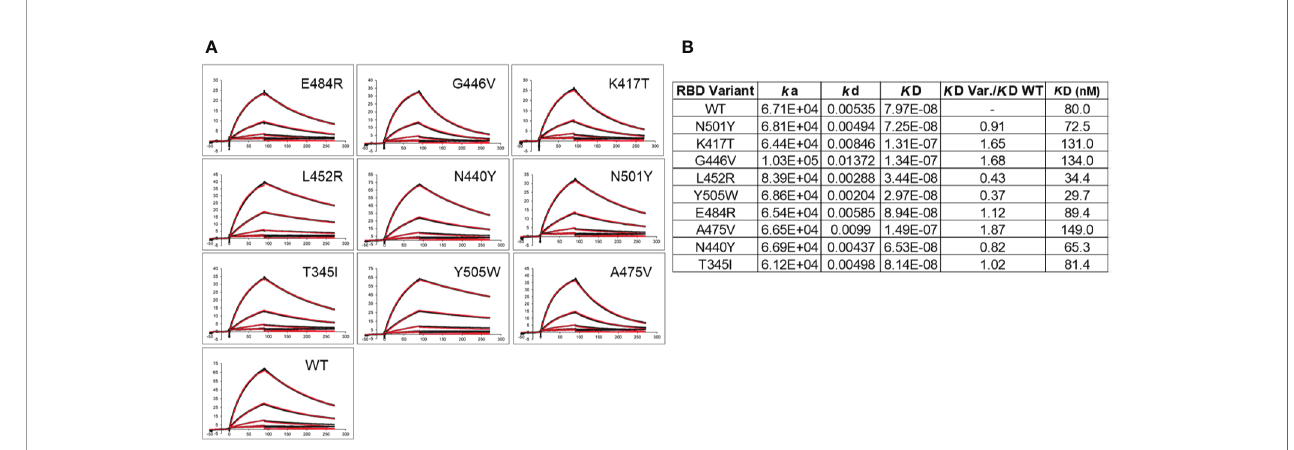
FIGURE 6 | ACE2 binding to SARS-CoV-2 S RBD variants. (A) Sensorgrams of RBD variants binding to ACE2. Black lines correspond to the experimental sensorgram data and the red lines correspond to the calculated sensorgrams used to de fi ne the binding constants. Units of the x and y axes of each sensorgram are seconds and response units (RU), respectively. (B) Binding constants derived from the sensorgrams.